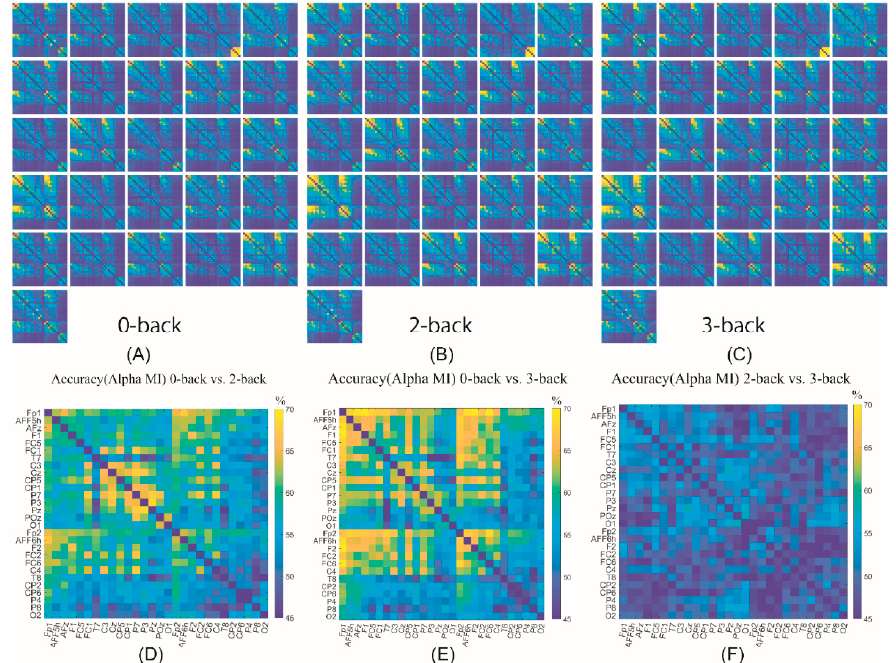
Figure 8. The heat map of MI FBC features and the accuracy results. ( A – C ) shows the MI value for each participant in 0-back, 2-back, and 3-back task. ( D – F ) represents the classification accuracy for 0-back vs. 2-back, 0-back vs.3-back and 2-back vs. 3-back, respectively, using each pair of EEG channels as the input where the FBC value was estimated by MI.